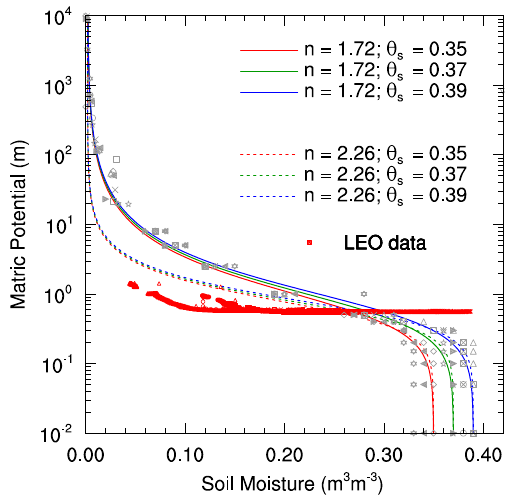
Figure 4. The relationship between soil moisture and matric poten- tial from laboratory experiments (the grey markers represent differ- ent sampling depths) and from the van Genuchten fitting curves for different porosities. The solid curves attempt to match the labora- tory data with n =1.72 while the dashed curves are from a particle size distribution analysis and match better the in situ LEO data (red symbols) with n